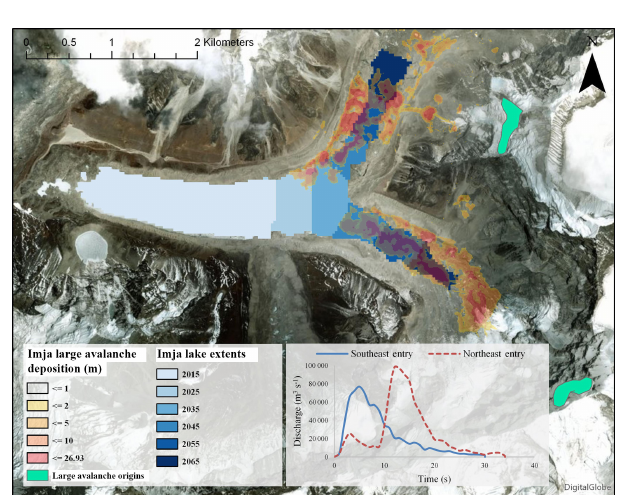
Figure 5. Deposition from the two large avalanche scenarios su- perimposed over estimated future lake extents, and time series of avalanche material entry into the lake for the 2045 estimated lake extents (inset). The northeast avalanche enters perpendicularly to the lake expansion trajectory, whereas the southeast avalanche en- ters with an almost direct trajectory toward the terminal